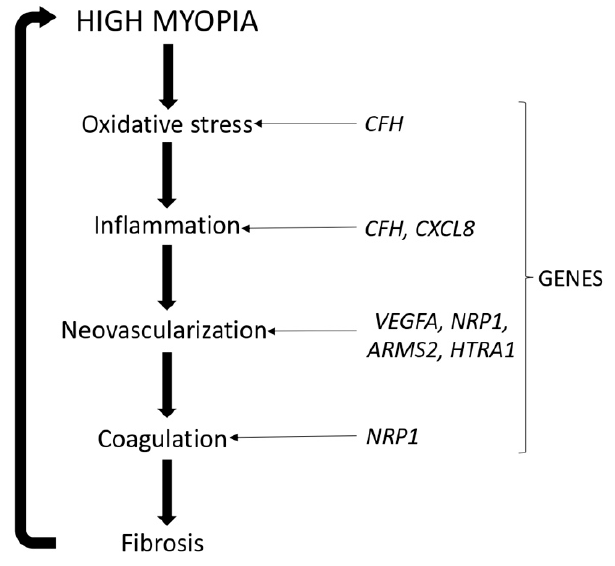
Figure 1. High myopia and related genes.